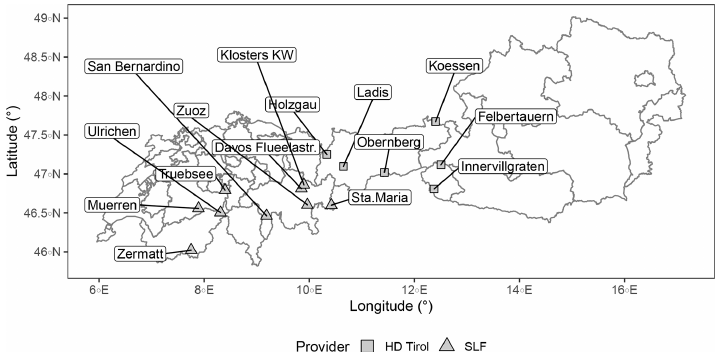
Figure A1. Locations of the stations used for calibration and validation. Austrian stations are operated by the Hydrographic Service of Tyrol (HD Tirol), and the Swiss stations by the Swiss Federal Institute for Forest, Snow and Landscape Research (WSL) Institute for Snow and Avalanche Research SLF. See Table A1 and text for more details.